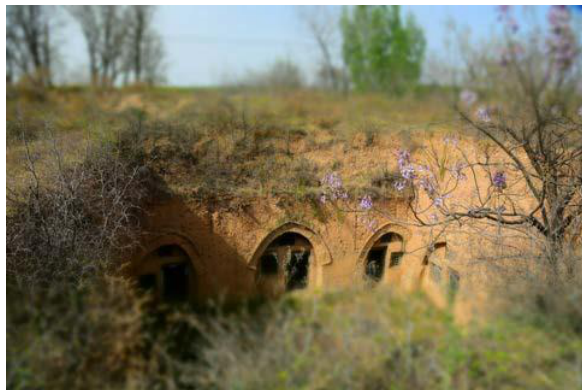
Figure 3. A sunken cave dwelling in Yangjiayao